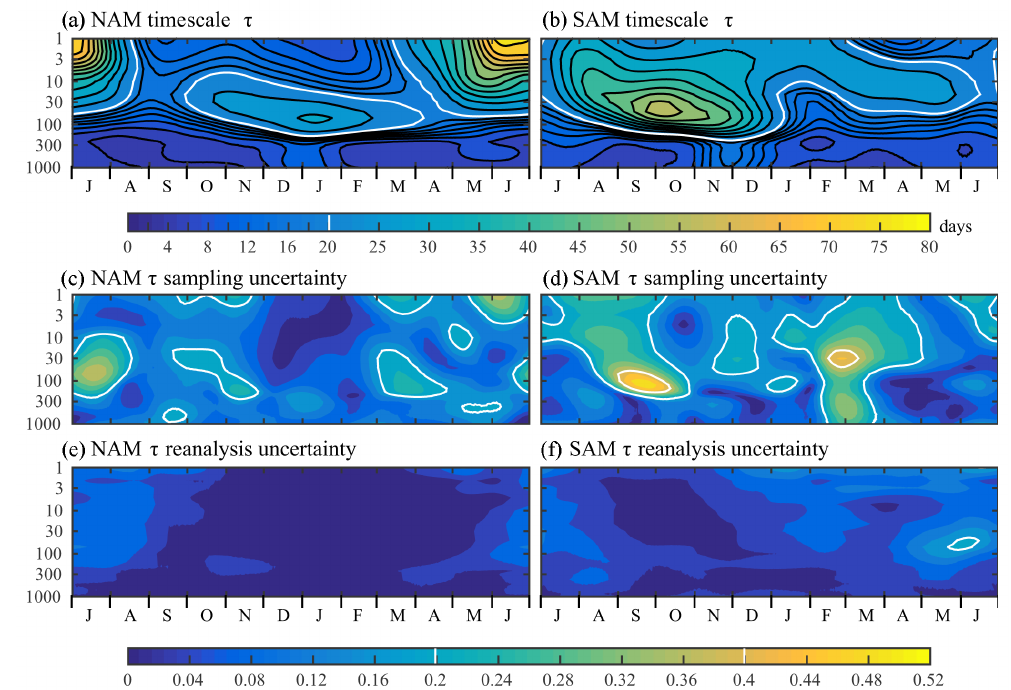
Figure 12. The annual cycle in the timescale of annular mode variability, τ , and relative uncertainty associated with the finite record and spread between the reanalyses. As detailed in the text, the top panels show the decorrelation timescale τ of the (a) Northern and (b) Southern Annular Modes in JRA-55 analysis, based on the average of 5 and 3 independent decadal calculations (1960–1969, 1970–1979, ... , 2000– 2009 for the NH, only the last 3 decades for the SH). The middle panels show the sampling uncertainty of τ for (c) the NAM and (d) the SAM: the standard deviation of the decadal calculations divided by the square root of the sample size (5 and 3, respectively). We show the uncertainty in a relative sense, normalizing by the mean timescale shown in the upper panels; otherwise errors in the troposphere (where τ is smaller) appear insignificant. The bottom panels show the reanalysis uncertainty in τ for the (e) NAM and (f) SAM: the standard deviation of τ between calculations using ERA-Interim, JRA-55, MERRA2, and CFSR. The standard deviation was computed across three separate decadal calculations (1980–1989, 1990–1999, and 2000–2009) and then